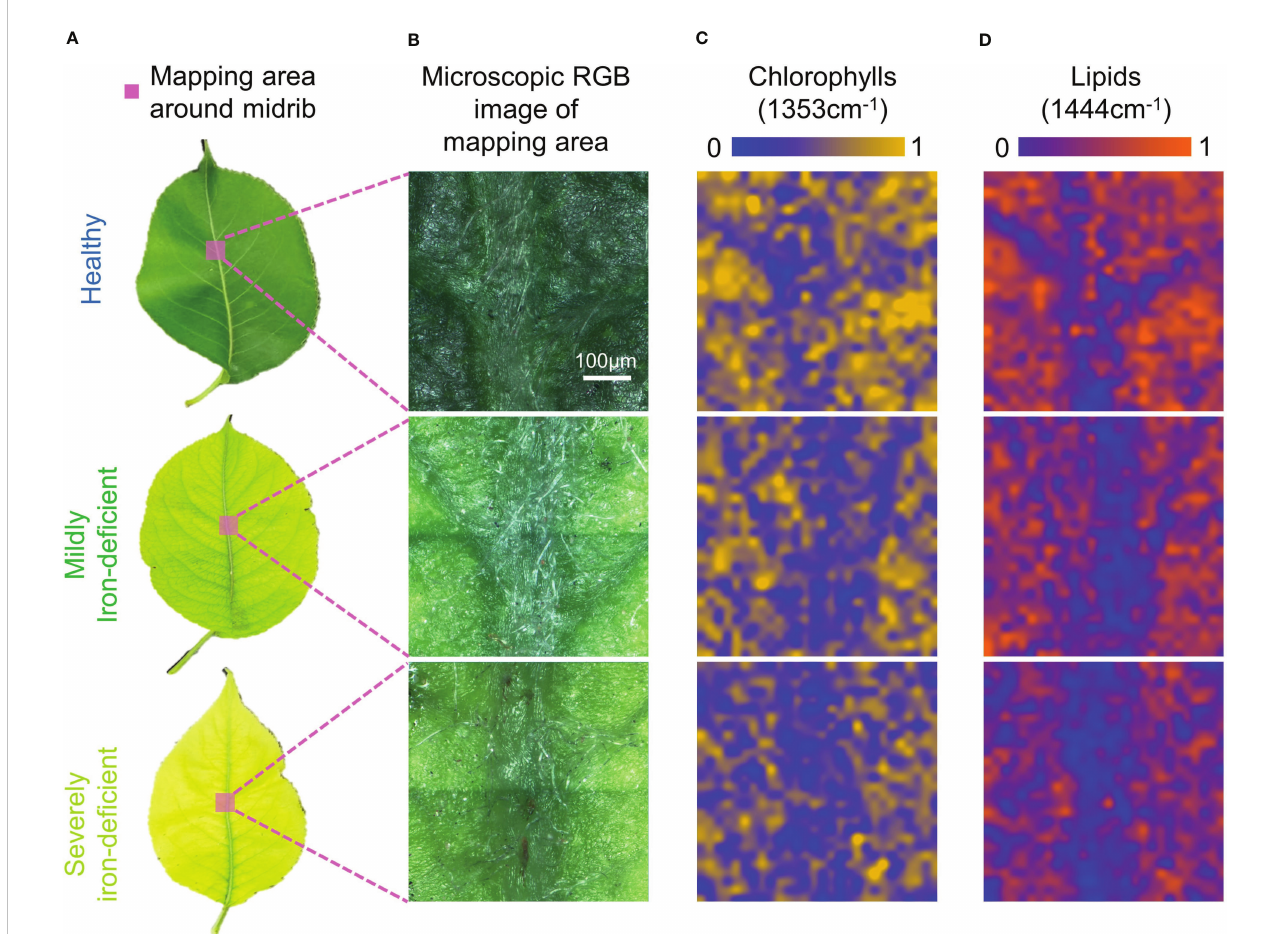
FIGURE 3 Visible light images and Raman spectral images of midrib components in leaves with differing degrees of iron de fi ciency. (A) Visible light images of healthy and iron-de fi cient leaves; (B) Microscopic visible light images of the midrib-mapping regions; (C) Pseudo-color maps of chlorophylls spatial distribution in the midrib-mapping regions; and (D) Pseudo-color maps of lipids spatial distribution in the midrib-mapping